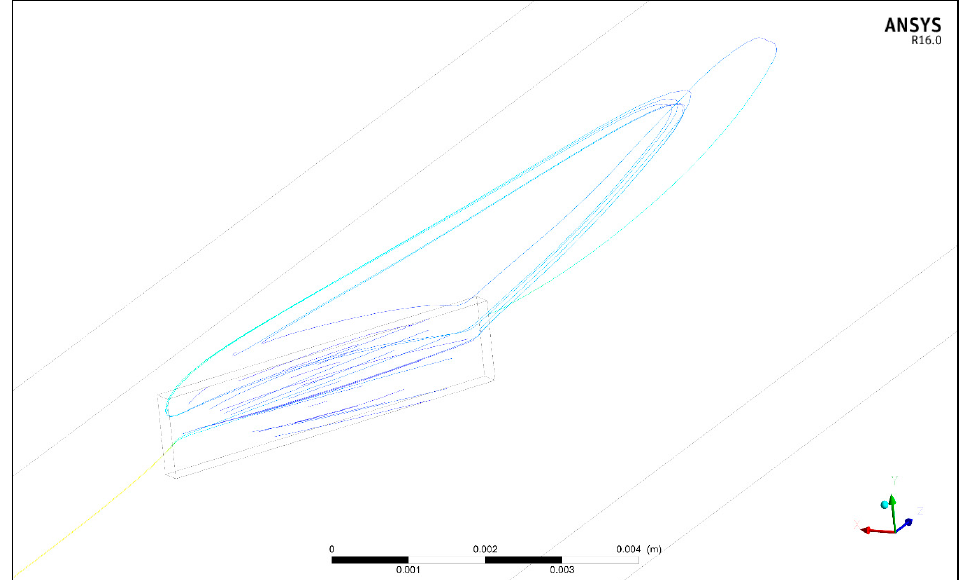
Figure 7. Flow pattern behind the VG at Re =1100.